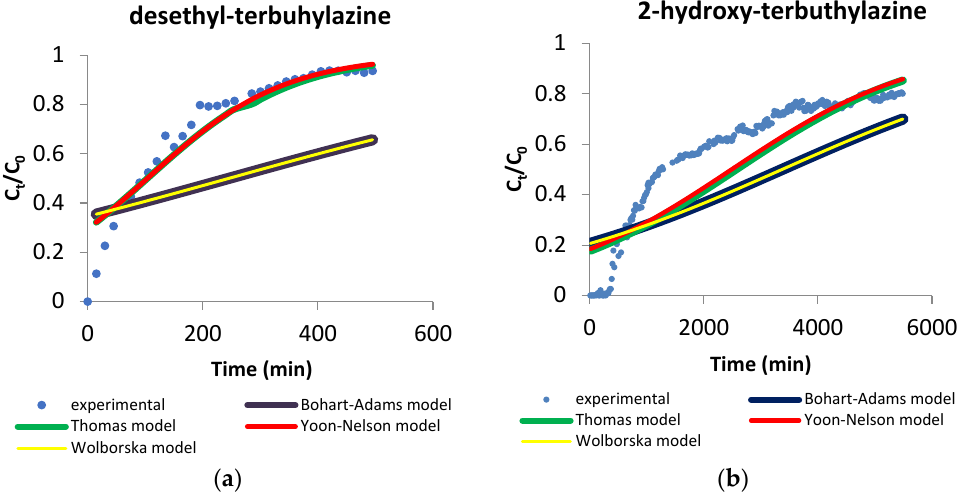
Figure 9. Experimentally obtained breakthrough curves and fixed bed column modeling curves for desethyl-terbuthylazine ( a ) and 2-hydroxy-terbuthylazine ( b ).